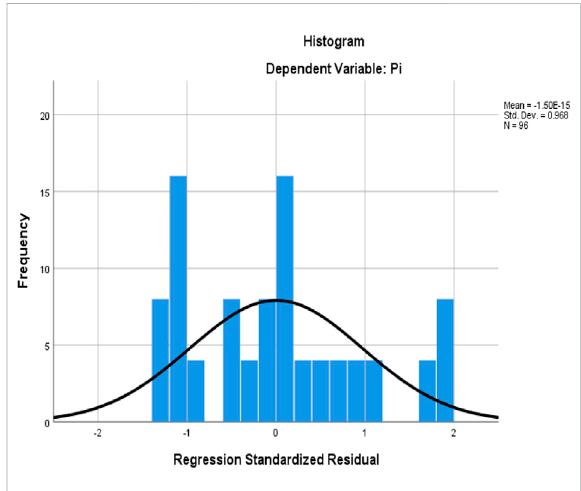
FIGURE 4 Histogram corresponding to the dependent variable for